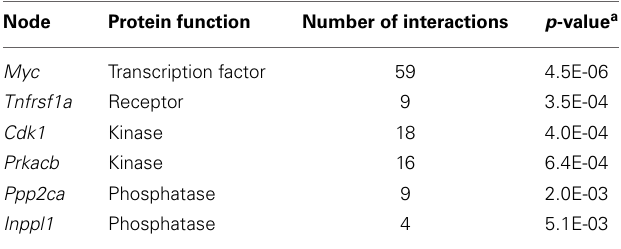
Table 2 | Over-connected nodes in network analysis of combined set of candidate